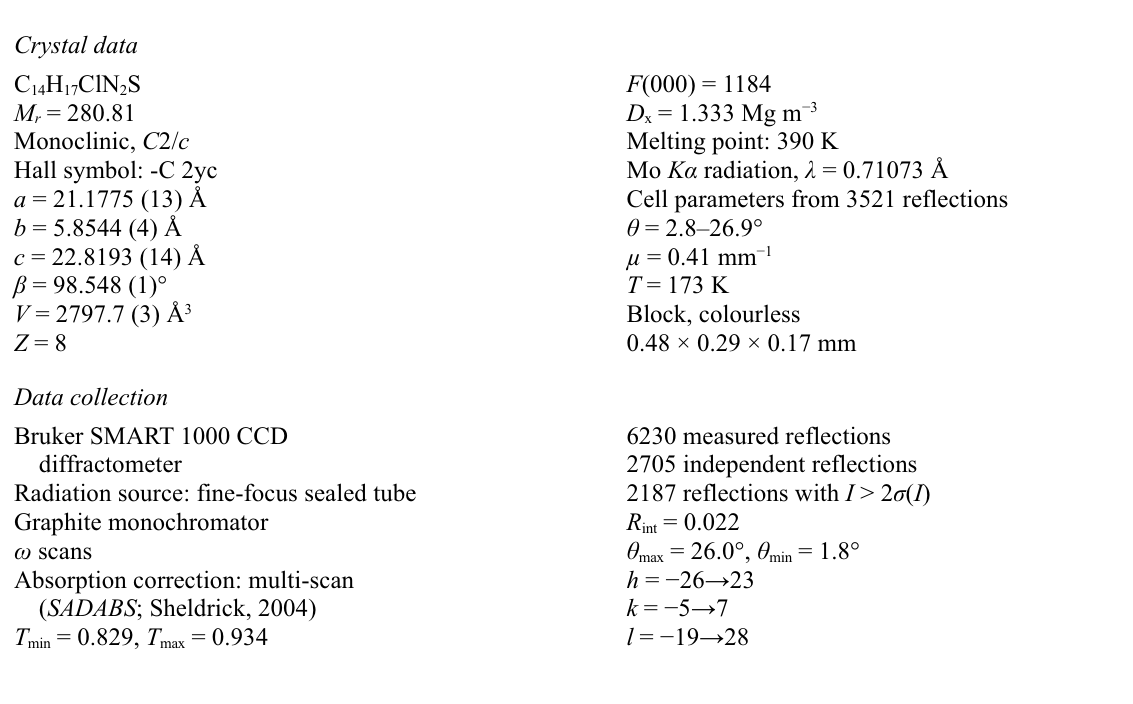
Packing diagram showing the N—H···N hydrogen bonds. 2-Amino-4- tert